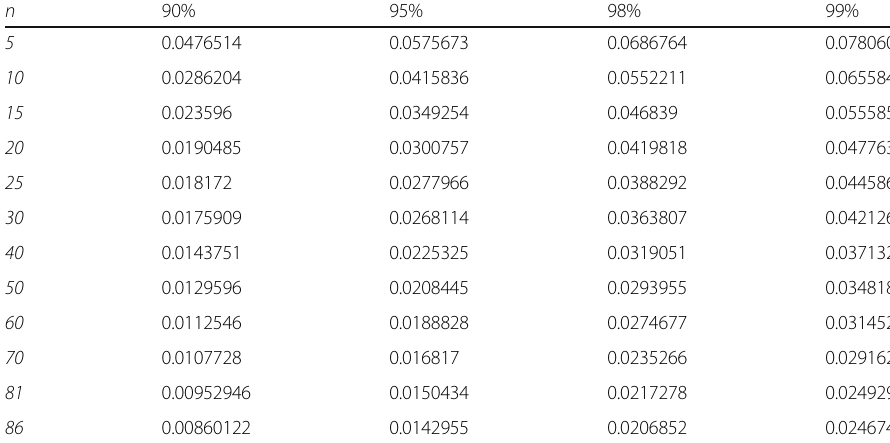
Table 4. The upper percentile of ^ Δ c ð s Þ with 5000 replications at s = 2 n